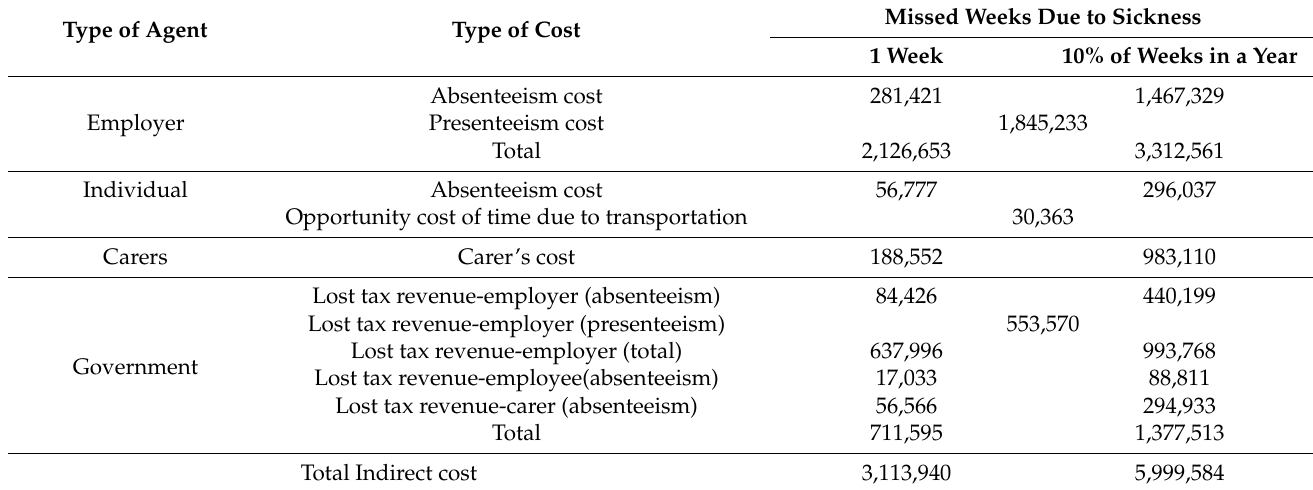
Table 8. Additional annual indirect costs due to LHL in the Blacktown